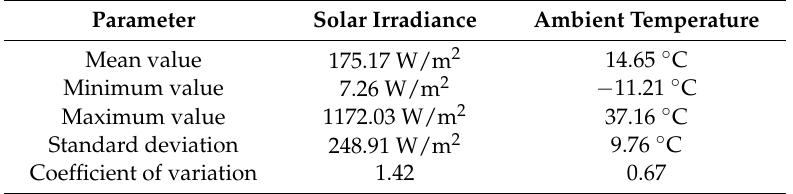
Figure 3. Daily mean values of the solar irradiation and ambient temperatures of 2018. Table 2. Statistical parameters of the solar irradiance and ambient temperatures of 2018.